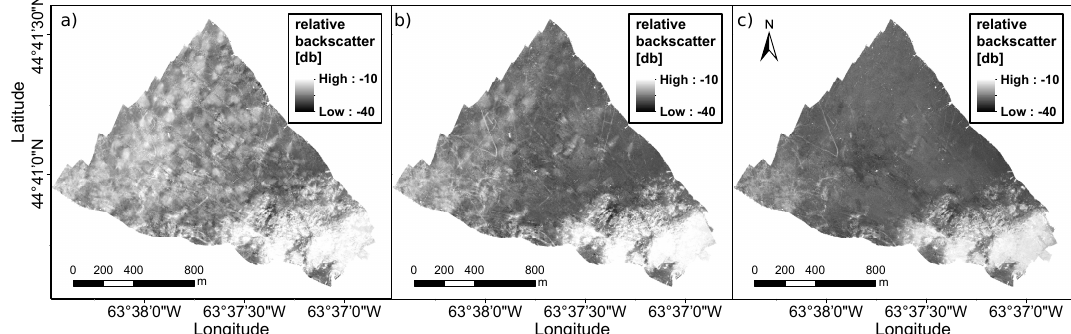
Figure 5. Backscatter mosaics of the 2016 dataset obtained from ( a ) 100, ( b ) 200, and ( c ) 400 kHz. The spatial resolution is 2m by 2m. Local Z-score with a sliding window of 100 pings is used to correct for the angular dependency